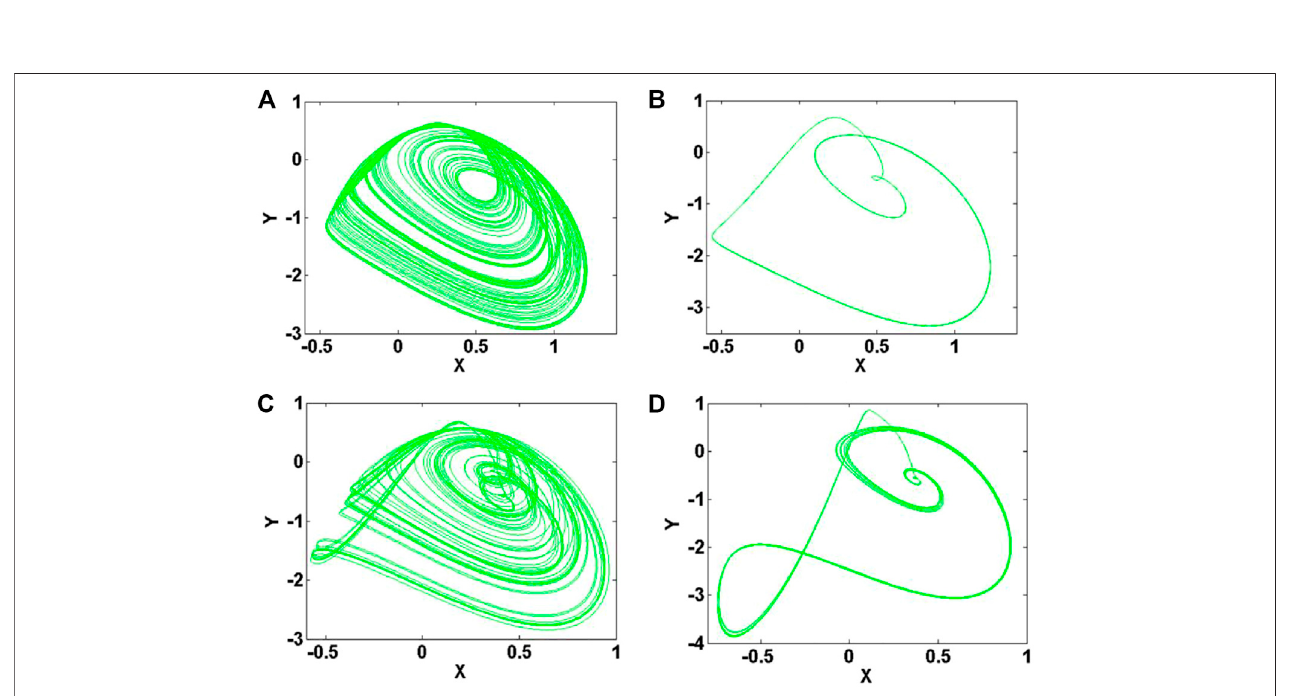
FIGURE 13 | Dynamics of system (10) with a (cid:1) 2.8, c (cid:1) 1.7, d (cid:1) 2.5 and initial condition (0, 0, 0): (A) b (cid:1) 5.5, (B) b (cid:1) 6.2, (C) b (cid:1) 9.2, (D) b (cid:1) 11.5.